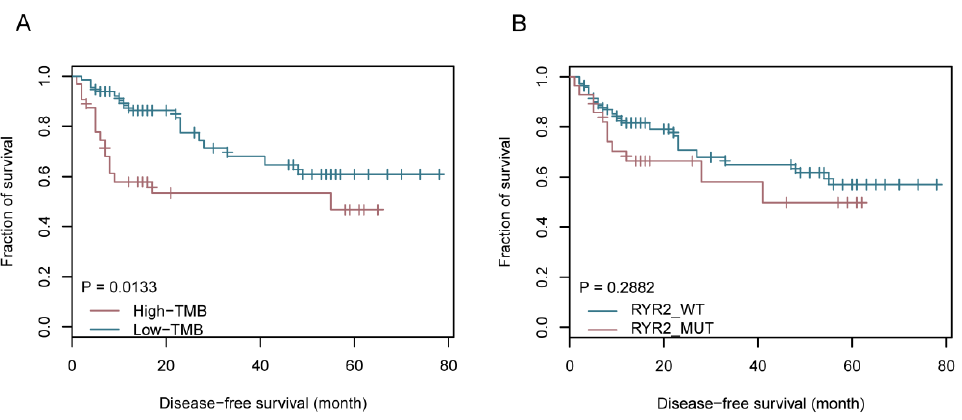
Figure 5. Prognostic significance of molecular subtyping based on TMB and RYR2 mutational status. ( A ) Patients with low TMB have a longer disease-free survival. ( B ) Patients without RYR2 mutation have a tendency to show a longer disease-free